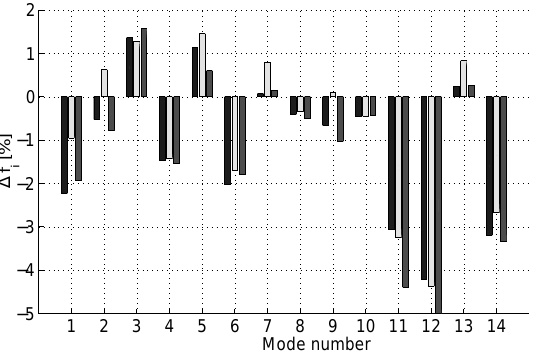
Fig. 13. Frequency deviation after modification 2 of the updated model: R&A dark gray, R&AV light gray, R&MAC medium gray.